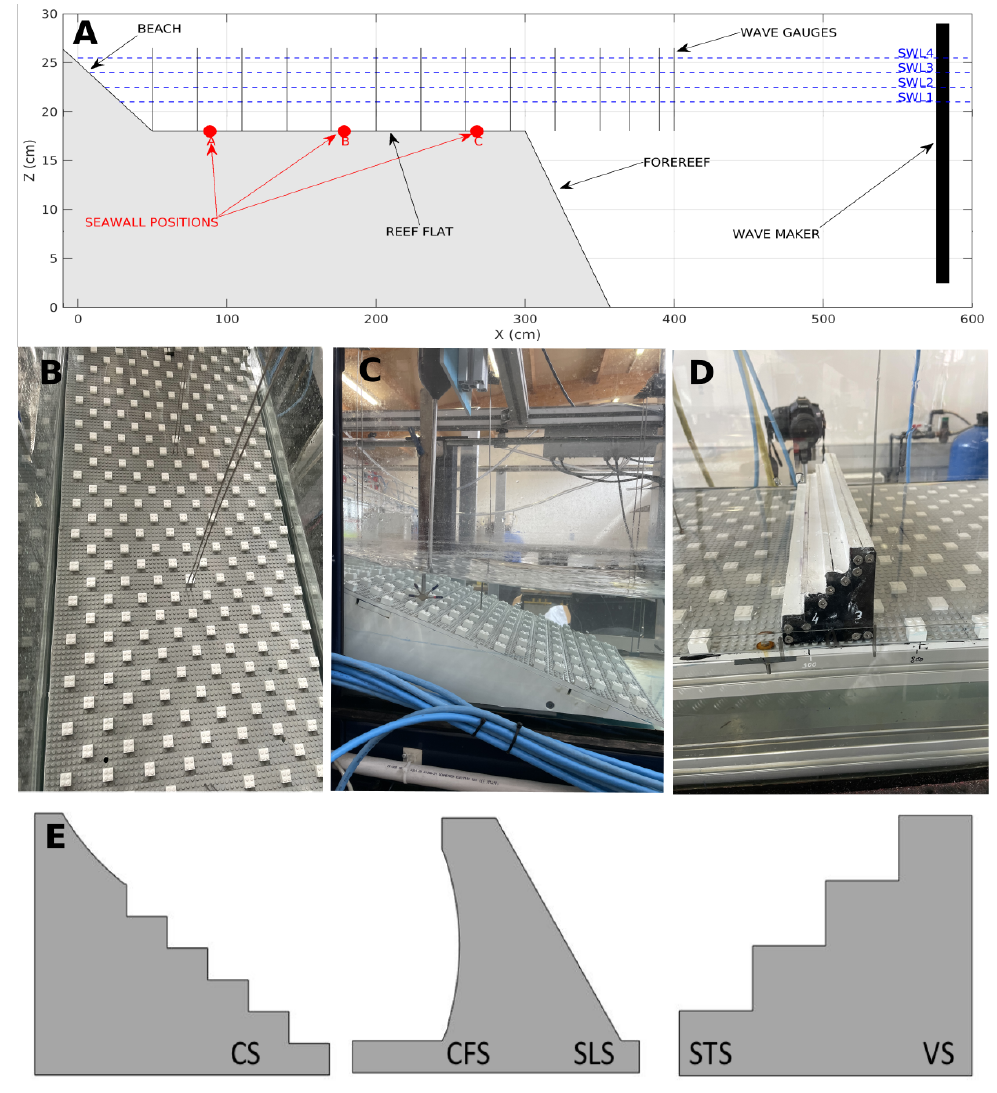
Figure 2. Experimental setup. ( A ): Bed profile and instrumentation. ( B ) and ( C ): Reef flat and forereef covered in plastic cubes. ( D ): Stepped seawall on the reef flat. ( E ): Tested seawall